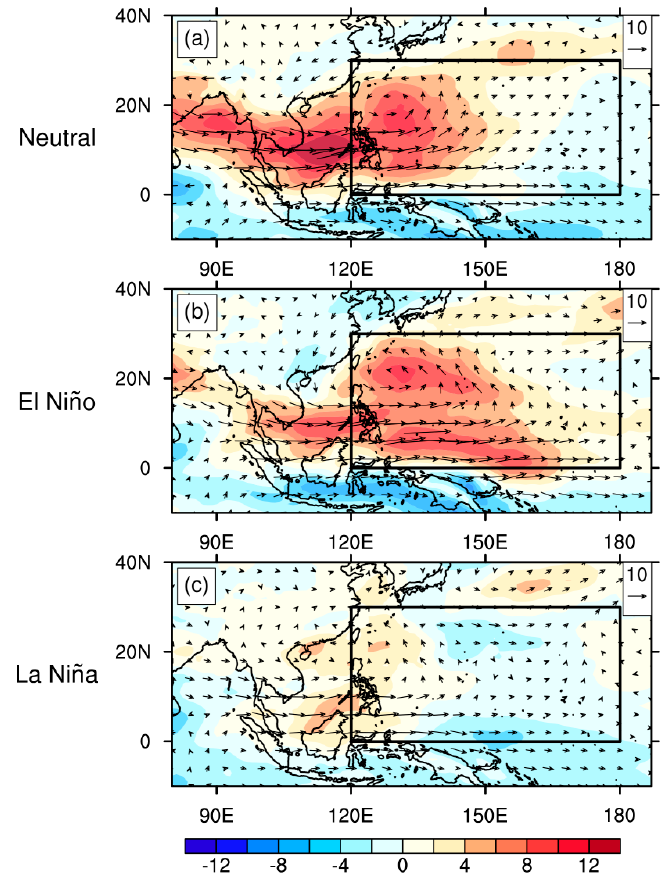
Figure 13. Di ff erences between the composites of filtered water vapor flux anomaly vertically integrated from 1000 to 500 hPa (vectors; unit: kg · m − 1 · s − 1 ) for the active and inactive MJO phases over the WNP during June–November over the period of 1979–2016, overlaid with the related magnitude of filtered water vapor flux anomaly (shaded; unit: kg · m − 1 · s − 1 ) in ( a ) neutral years, ( b ) the El Niño years, and ( c ) the La Niña years. The definition of the active and inactive phases for the MJO-related WNP TC genesis under di ff erent ENSO conditions is in Table 1.